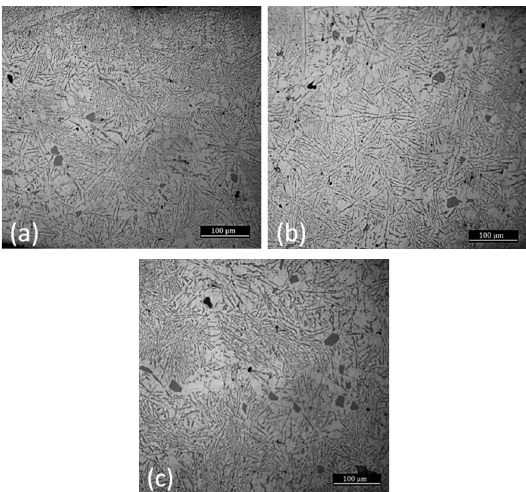
Figure 15. Eutectic silicon numeric fraction variation of samples poured at 635 °C with a section diameter of 0.7mm for different mold temperatures: 300 °C, 350 °C and 400 °C - [Zone 2].